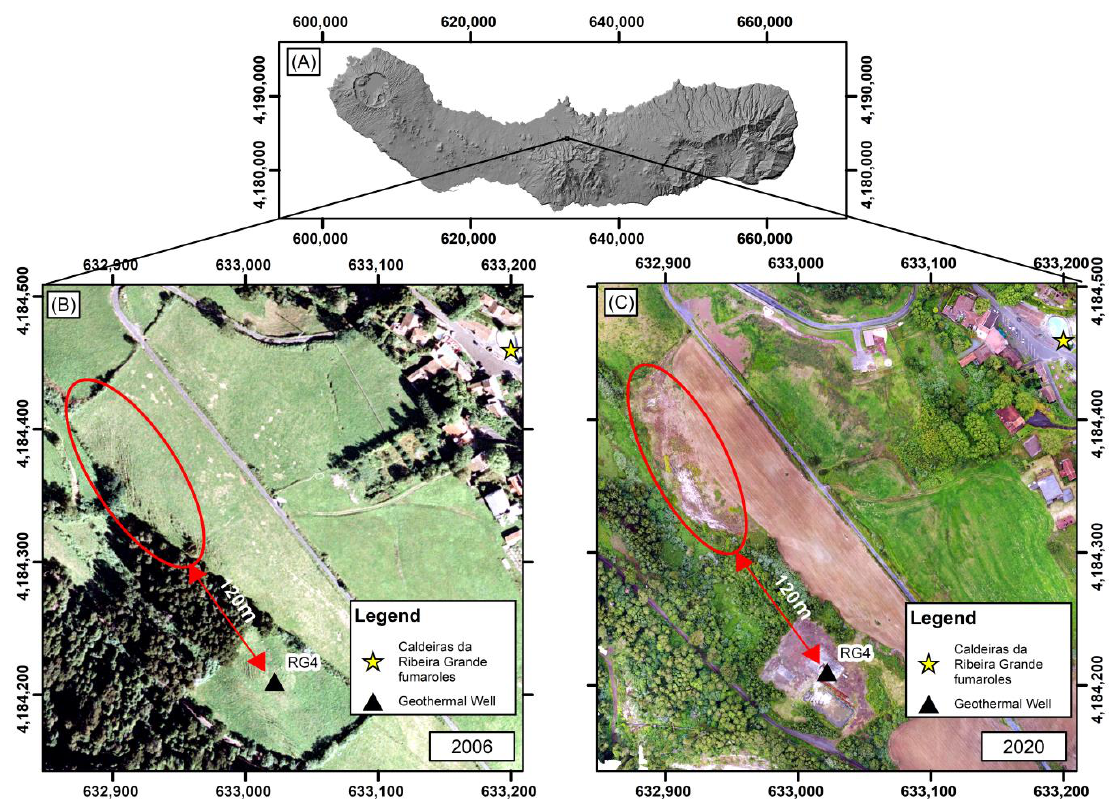
Figure 2. Location of the study area highlighting the surrounding area of the RG4 well (signed as a black triangle). ( A ) São Miguel DEM; ( B ) orthophoto map of the RG4 surrounding area in 2006, before the thermal anomaly; and ( C ) UAV RGB image after the thermal anomaly, 2020 (Source: CIVISA). The red line corresponds to the area with the highest concentration of anomalies and visible alteration of vegetation.